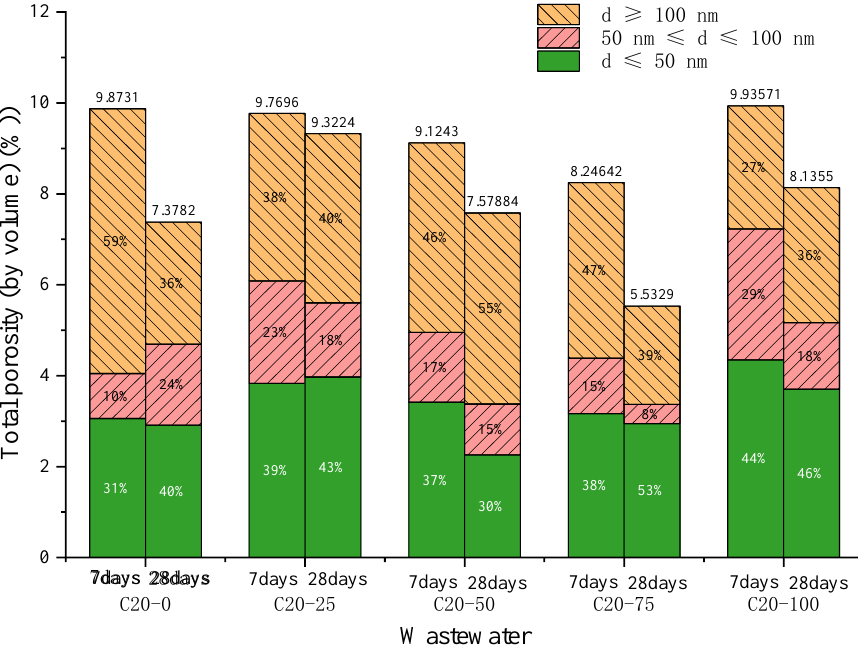
Figure 10. Porosity and pore volume of C20 concrete. According to Wu et al. [40], pores with d ≥ 100 nm are considered harmful, pores with 50 ≤ d ≤ 100 nm are considered less harmful, and pores with d ≤ 50 nm are con- sidered harmless. The pore structure distribution of C20 concrete samples with different proportions of wastewater to replace potable water is shown in Figure 10. At the age of 7 days, the pore structure changes as follows. When d ≥ 100 nm, com- pared with C20-0, the proportion of pores with d ≥ 100 nm in wastewater-mixed concrete decreased by 20.7% (C20-25), 36.1% (C20-50), 22.5% (C20-75), and 53.8%, respectively. When 50 ≤ d ≤ 100 nm, the proportion of 50 ≤ d ≤ 100 nm pores increased after adding wastewater. Compared with C20-0, the proportion of 50 ≤ d ≤ 100 nm pores in concrete increased by 129.1% (C20-25) and 67.6% (C20-50) with the increase in the proportion of wastewater as a replacement for potable water. When d ≤ 50 nm, compared with C20-0, the proportion of pores with d ≤ 50 nm in concrete with the increase in the proportion of wastewater as a replacement for potable water is 26.6% (C20-25), 20.8% (C20-50),